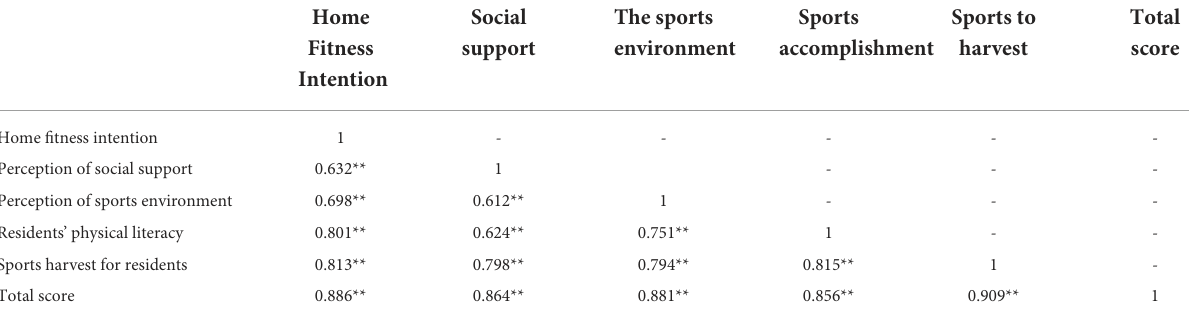
TABLE 4 Correlation coefficients between factors and total scores of the questionnaire on influencing factors of residents’ satisfaction with home fitness during the period of the epidemic.